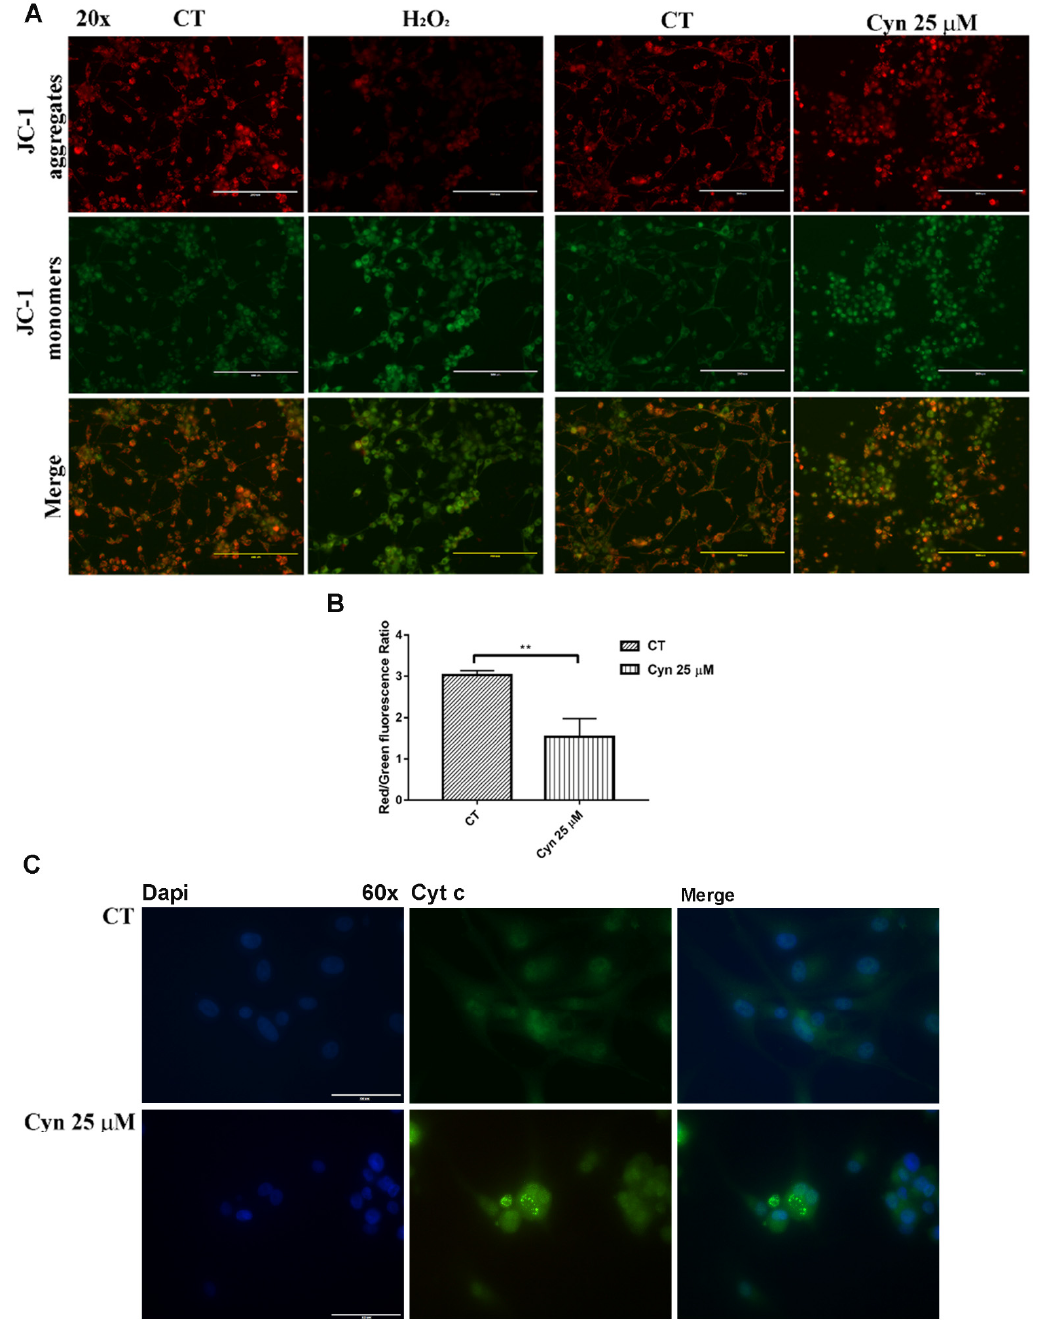
Figure 3. Effects of the ROS-inducing compound Cyn on the mitochondria. ( A ) Loss of the mito- chondrial membrane potential ( Ψ m) in U87-MG cells treated with Cyn 25 µ M for 24 h, evaluated by the JC-1 assay. DMSO 0.1% was used as the vehicle control, while exposure to H 2 O 2 10 µ M for 30 min was the positive control. ( B ) Quantitative analysis of Ψ m was estimated as a red/green fluorescence ratio in the same conditions using ImageJ software v. 1.53. Data were analyzed by the Student’s t -test, p -value < 0.05. According to GraphPad Prim 7 software, a ** p -value from 0.001 to 0.01 was considered very significant. ( C ) Immunofluorescence staining of Cyt c in 25 µ M Cyn-treated U-87 MG cells for 24 h. DMSO 0.1% was used as the vehicle control. In U-87 MG cells treated with 25 µ M Cyn for 24 h, Cyt c staining appeared much more punctate, a common feature indicative of mitochondrial fragmentation, rather than distributed throughout the cell body. Magnification 60 ×